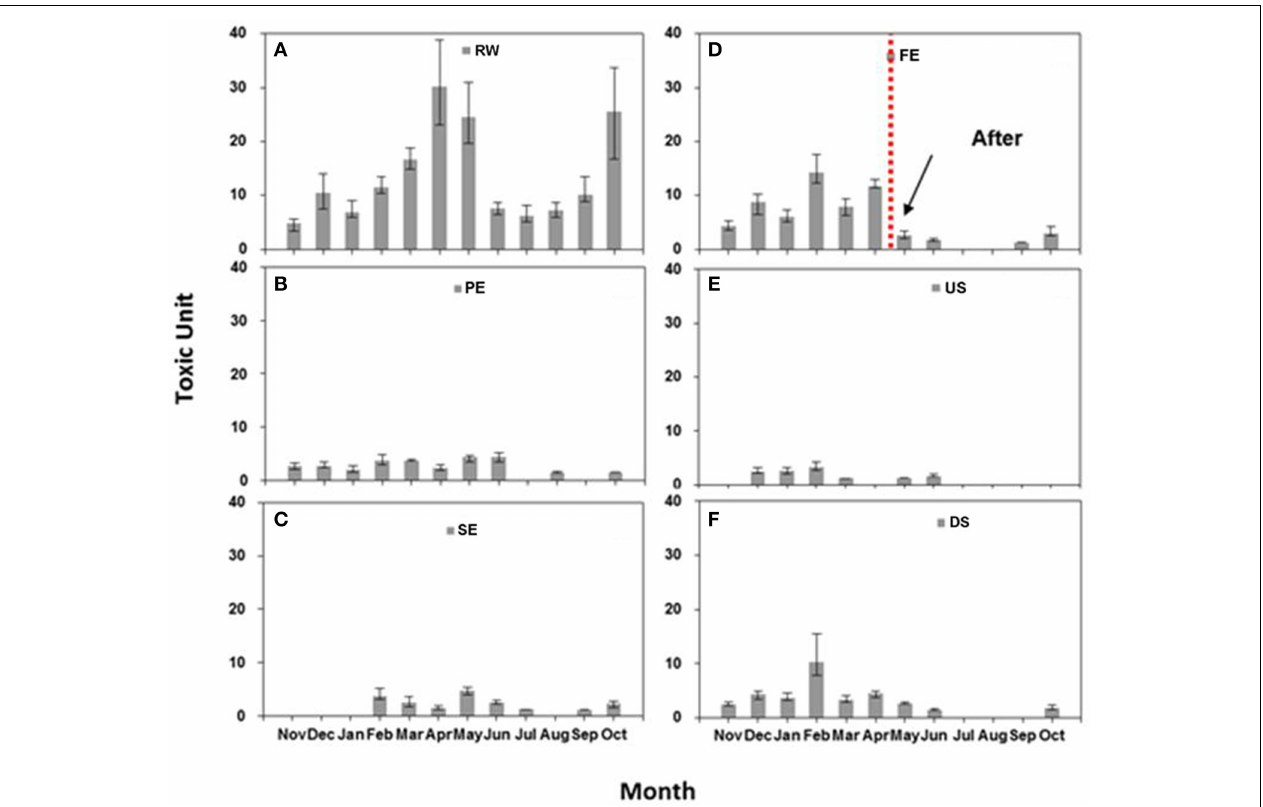
FIGURE 2 | Toxicity monitoring of WTP effluents and adjacent stream waters. (A–F) indicate toxic units measured in each sampling point: (A) raw wastewater (RW); (B) primary effluents (PE); (C) secondary effluents (SE); (D) final effluents (FE); (E) upstream water